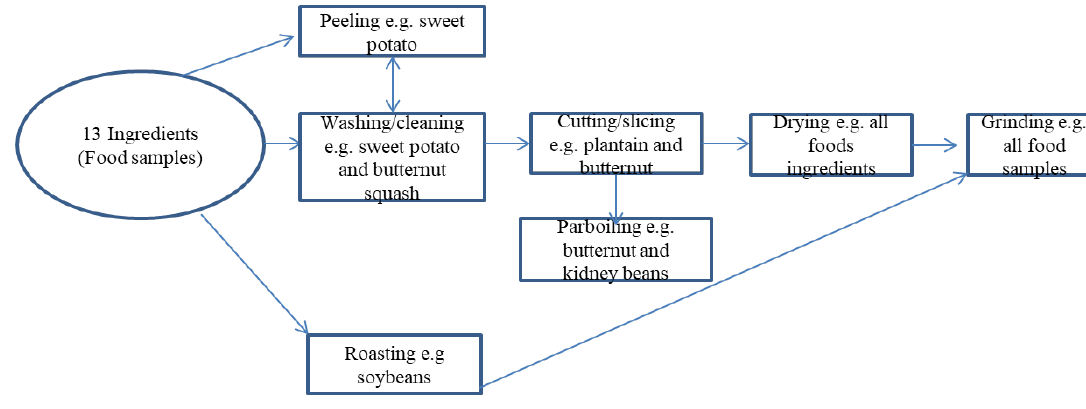
Figure 2. Food sample processing.